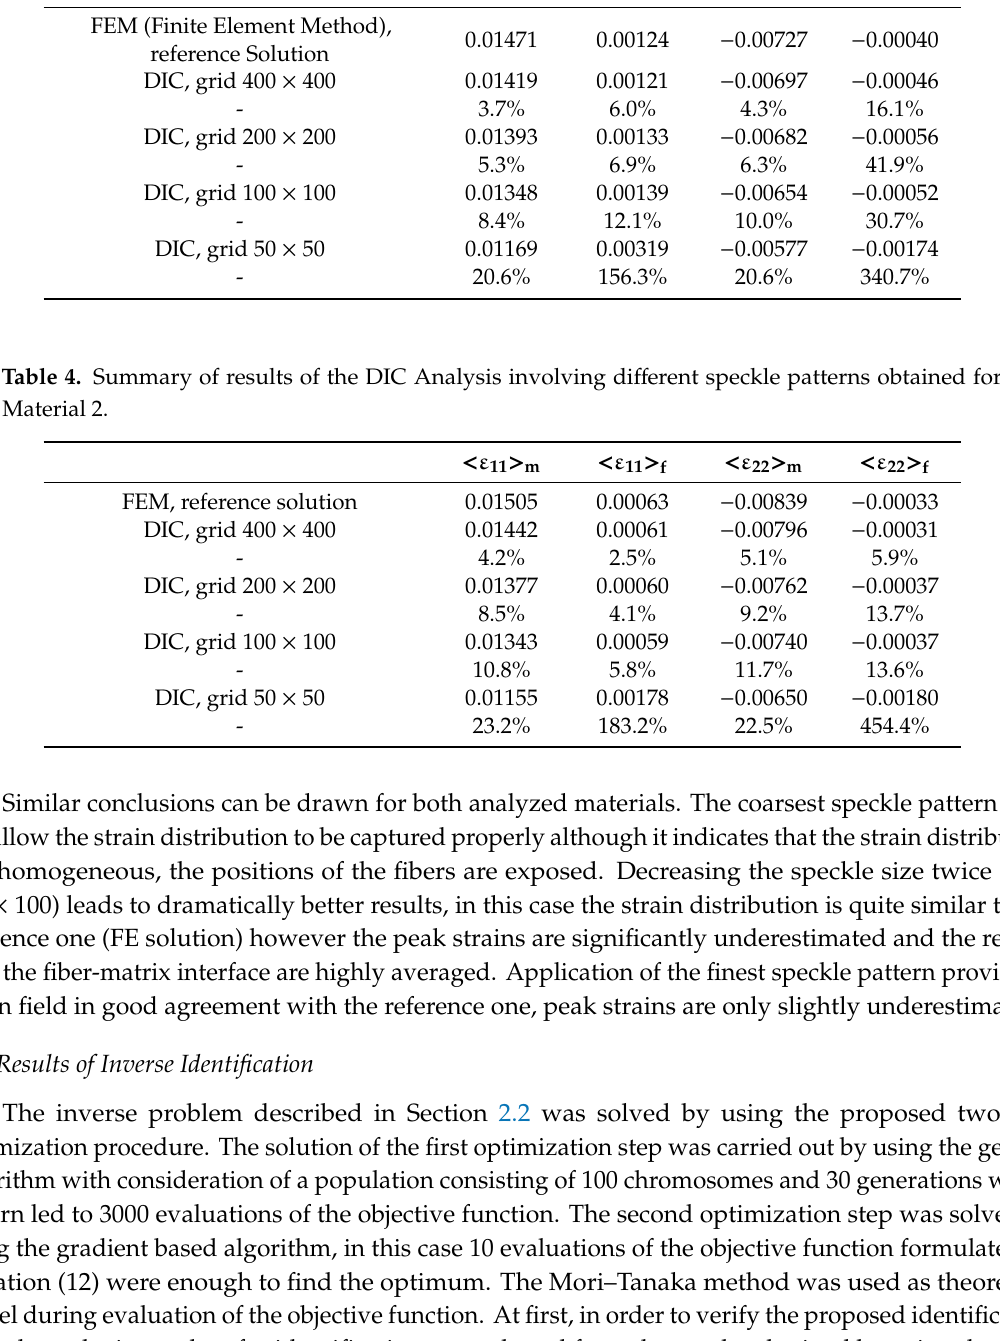
Table 3. Summary of results of the DIC (Digital Image Correlation) analysis involving di ff erent speckle patterns obtained for Material 1.